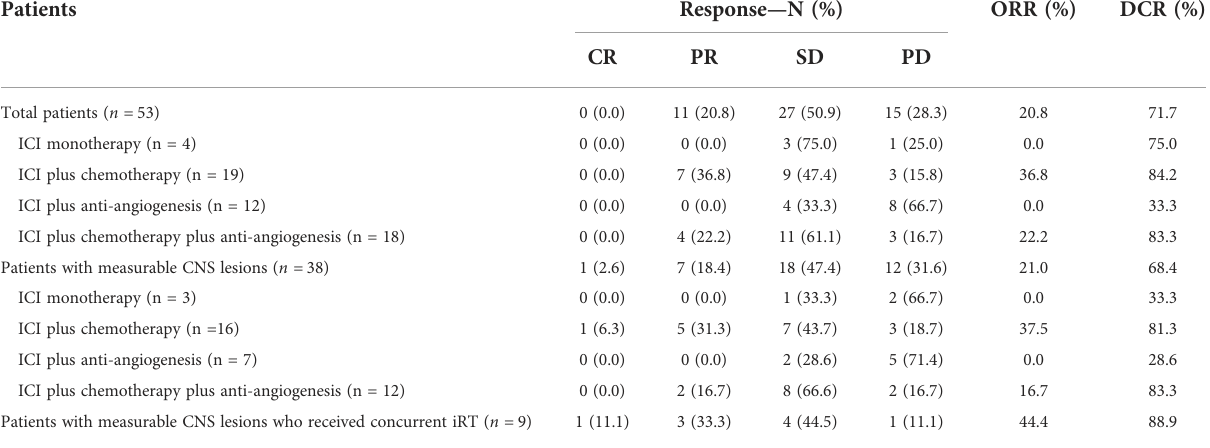
TABLE 2 Treatment response to ICI